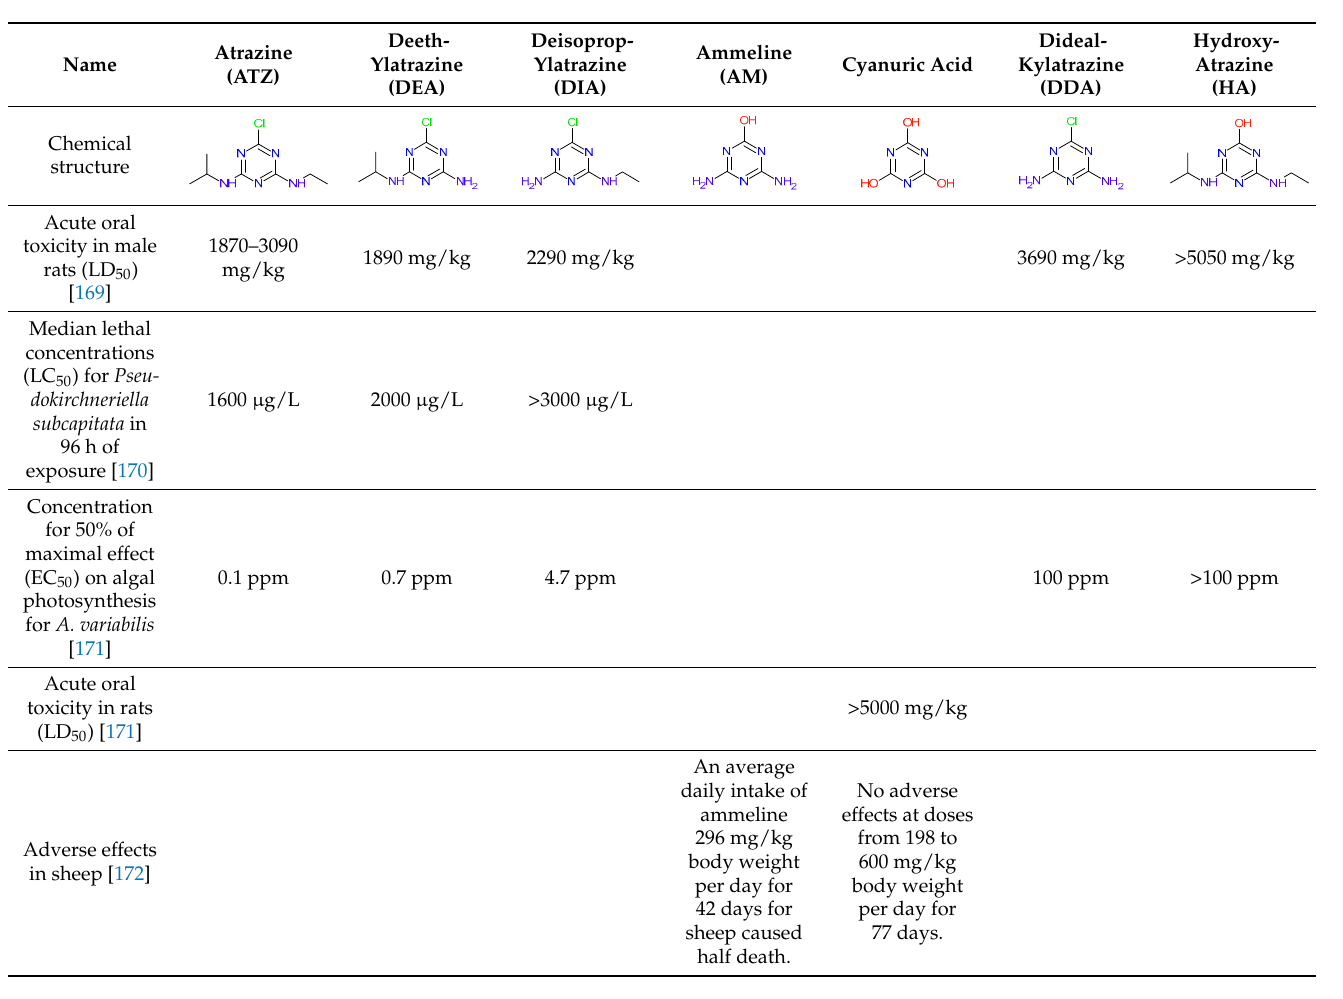
Table 8. Chemical structures and toxicity tests data of atrazine and its metabolites.